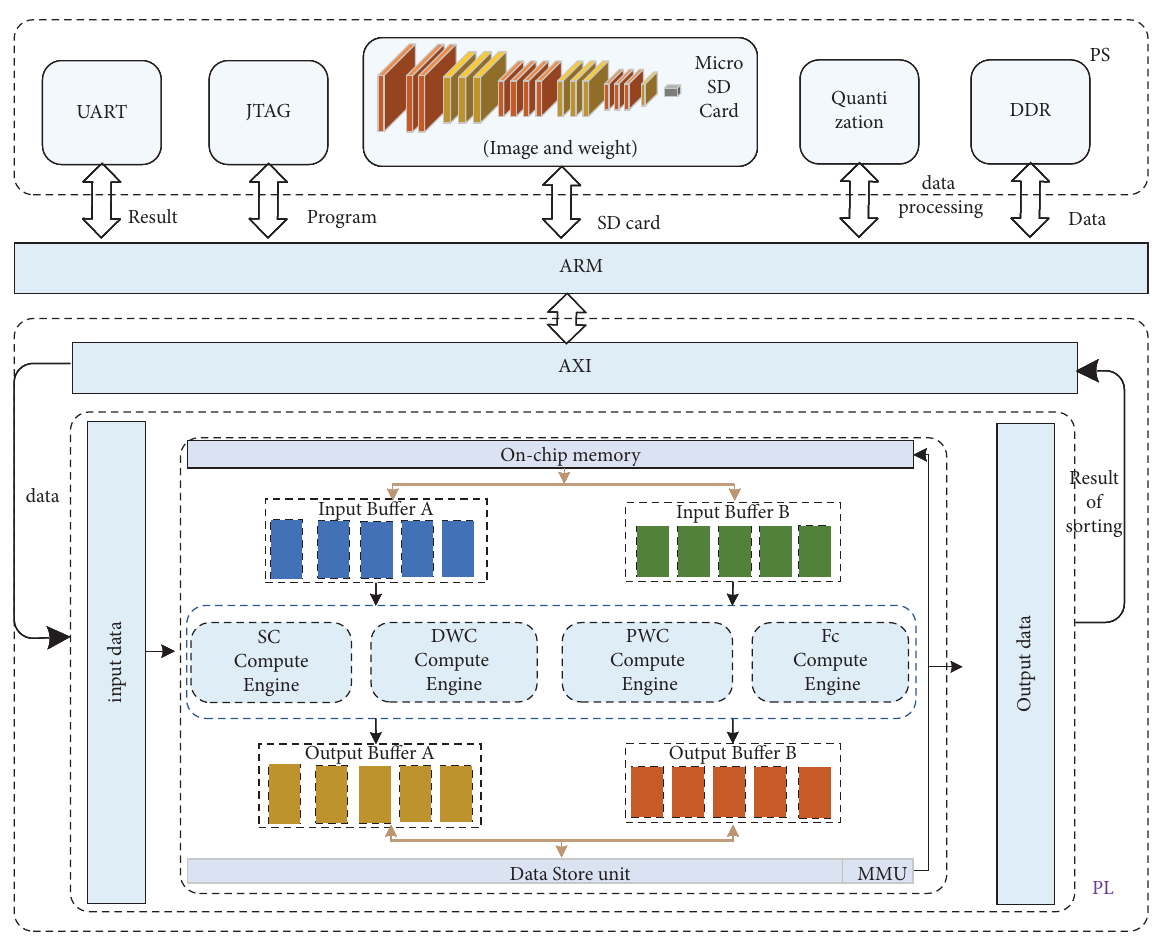
Figure 2: Te architecture of FPGA-based MobileNetV2